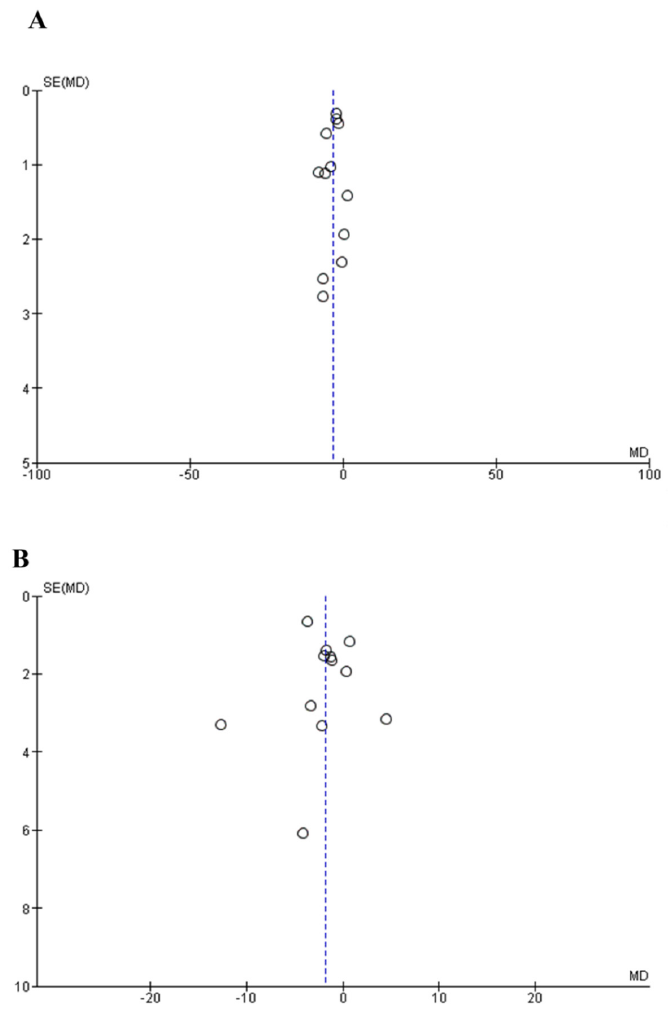
Figure 4. Funnel plot measuring publication bias and the effects of peptide intervention on SBP ( A ) and DBP ( B ). The X axis represents mean difference (MD) and the Y axis represents standard error (SE) of the MD.